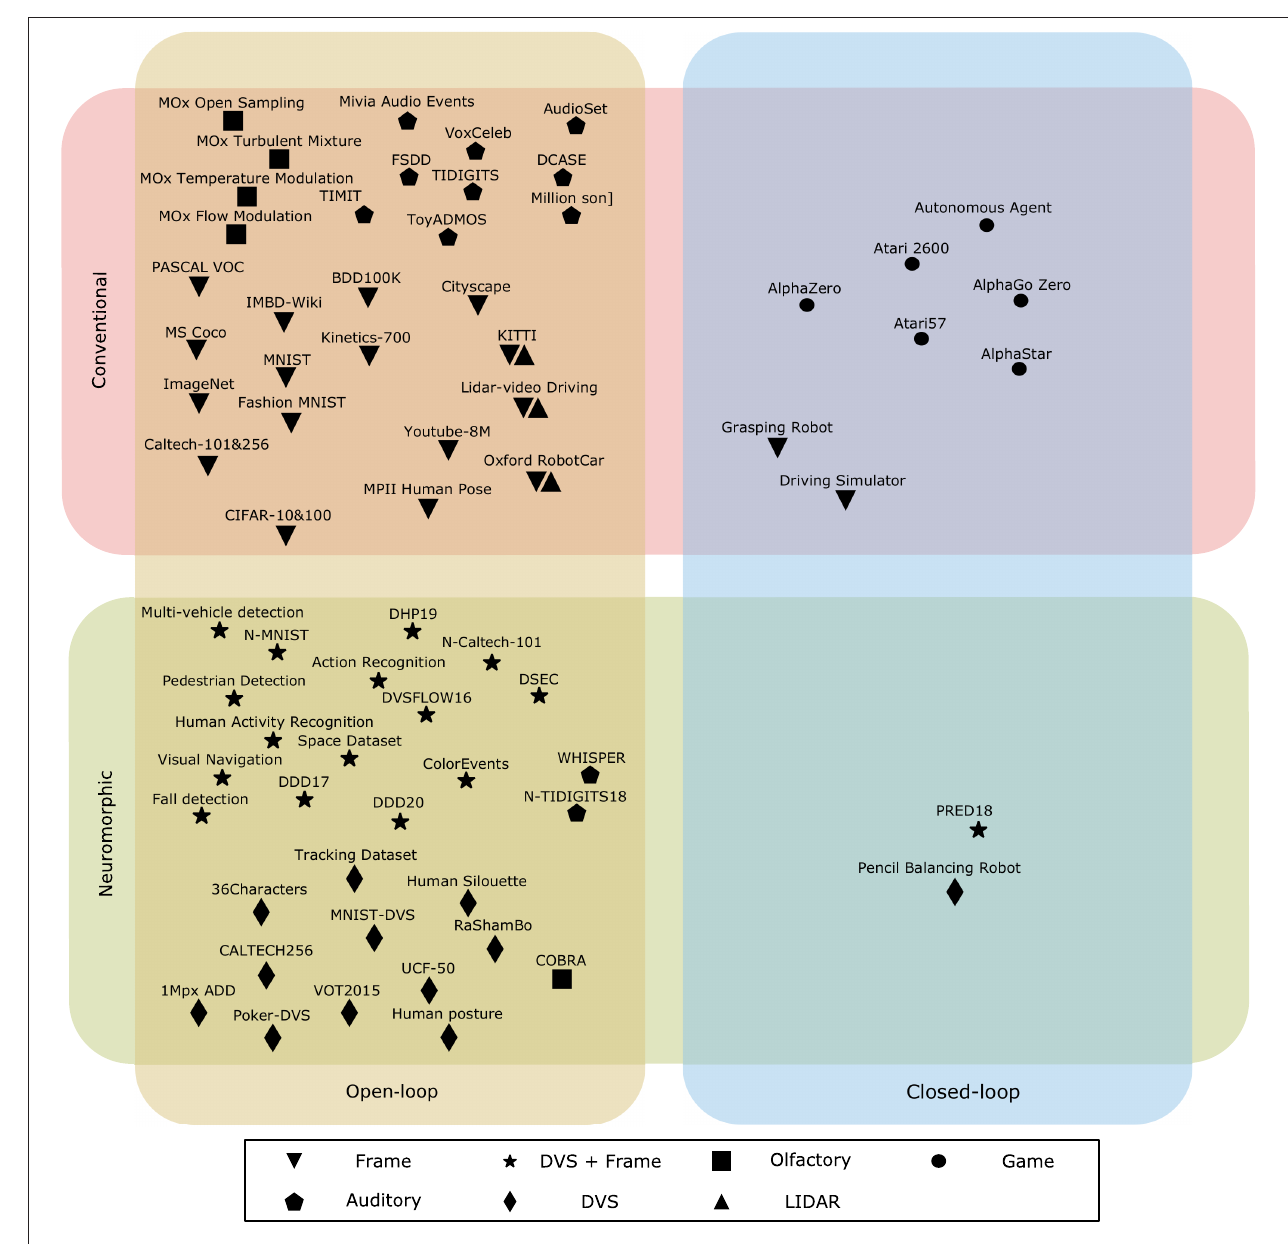
FIGURE 3 | Overview of existing open- and closed-loop datasets and benchmarks for conventional time-varying and neuromorphic time-continuous approaches to machine intelligence. Distribution of high-end challenges according to the research field (neuromorphic/conventional), their interactions with the environment (open- and closed-loop), and the sensing modality. Downward triangle: conventional frame-based cameras; Diamond: neuromorphic event-based cameras; Star: Combination of conventional frame- and neuromorphic event-based cameras; Pentagon: auditory sensors; Square: olfactory sensors; Triangle: LiDAR sensors; Circles: abstract games operating directly on machine code. Further details are provided in Tables 1 , 2 . While not being completely exhaustive, this figure underlines the gravitation of both machine and neuromorphic intelligence community towards open-loop datasets. In order to showcase and truly contribute to the advancement of machine intelligence, the neuromorphic community needs to focus their efforts on creating closed-loop neuromorphic benchmarks that are physically embedded in their environment and thus dictate a hard power and execution time constraint. While the physical set-ups in Moeys et al. (2016) and Conradt et al. (2009) could have formed the basis of closed-loop benchmarks, they were not developed as such. In Moeys et al. (2016), the set-up was used to generate an open loop static dataset and in Conradt et al. (2009), no dataset was generated. In contrast, the benchmarks advocated here would be available as physical experimental set-ups that can be accessed by the community for algorithm